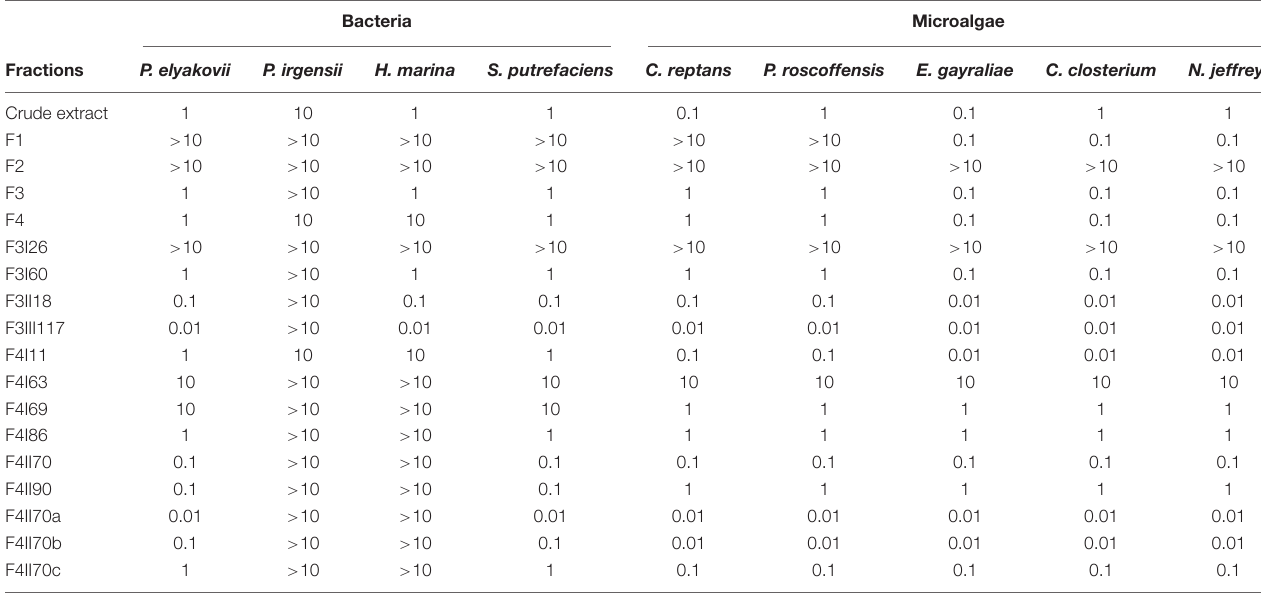
TABLE 1 | Antifouling activity of extract, fractions and sub-fractions from S. vulgare against bacteria ( Pseudoalteromonas elyakovii , Halomonas marina , Shewanella putrefaciens , and Polaribacter irgensii ) and microalgae ( Chlorarachnion reptans , Pleurochrysis roscoffensis , Exanthemachrysis gayraliae , Cylindrotheca closterium , and Navicula jeffreyi